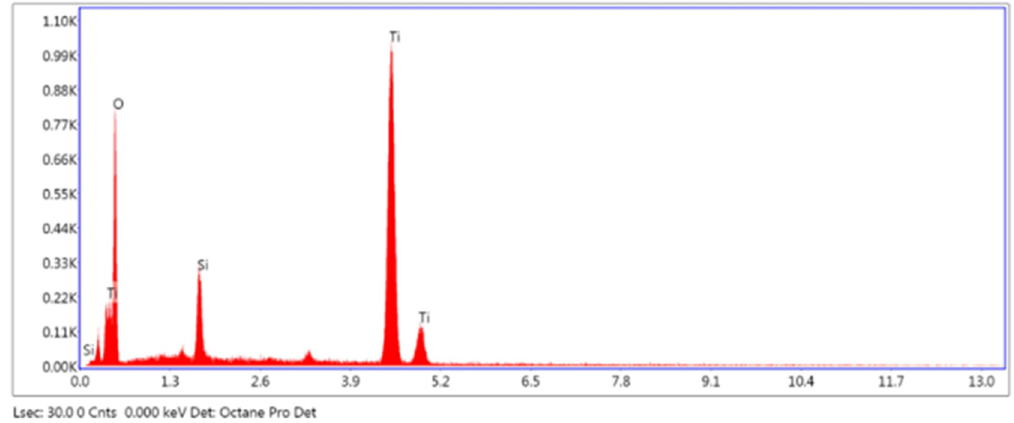
Figure 4. EDS of TiO 2 / SiO 2 composite. Table 4. TiO 2 / SiO 2 composite particle size analysis (PSA)